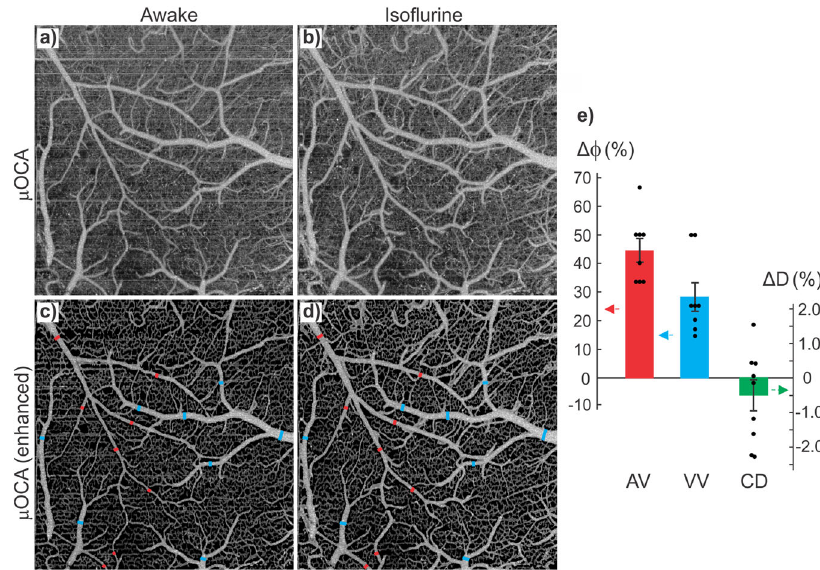
Fig. 3 3D μ OCA images of mouse sensorimotor cortex in awake vs iso fl urane (Iso) anesthetized states. a , b Raw μ OCA images of awake vs Iso states; c , d their corresponding enhanced μ OCA images by deep-learning processing; e statistical analyses of iso fl urane-induced vasodilation in arteriolar vessels (AV), venular vessels (VV), and capillary density (CD). Image size: 2.3 × 1.2 × 2.5 mm 3 . Red and blue bars represent arteriolar and venular vessel size changes ( Δ ϕ ), green bar represents capillary density change ( Δ D) due to